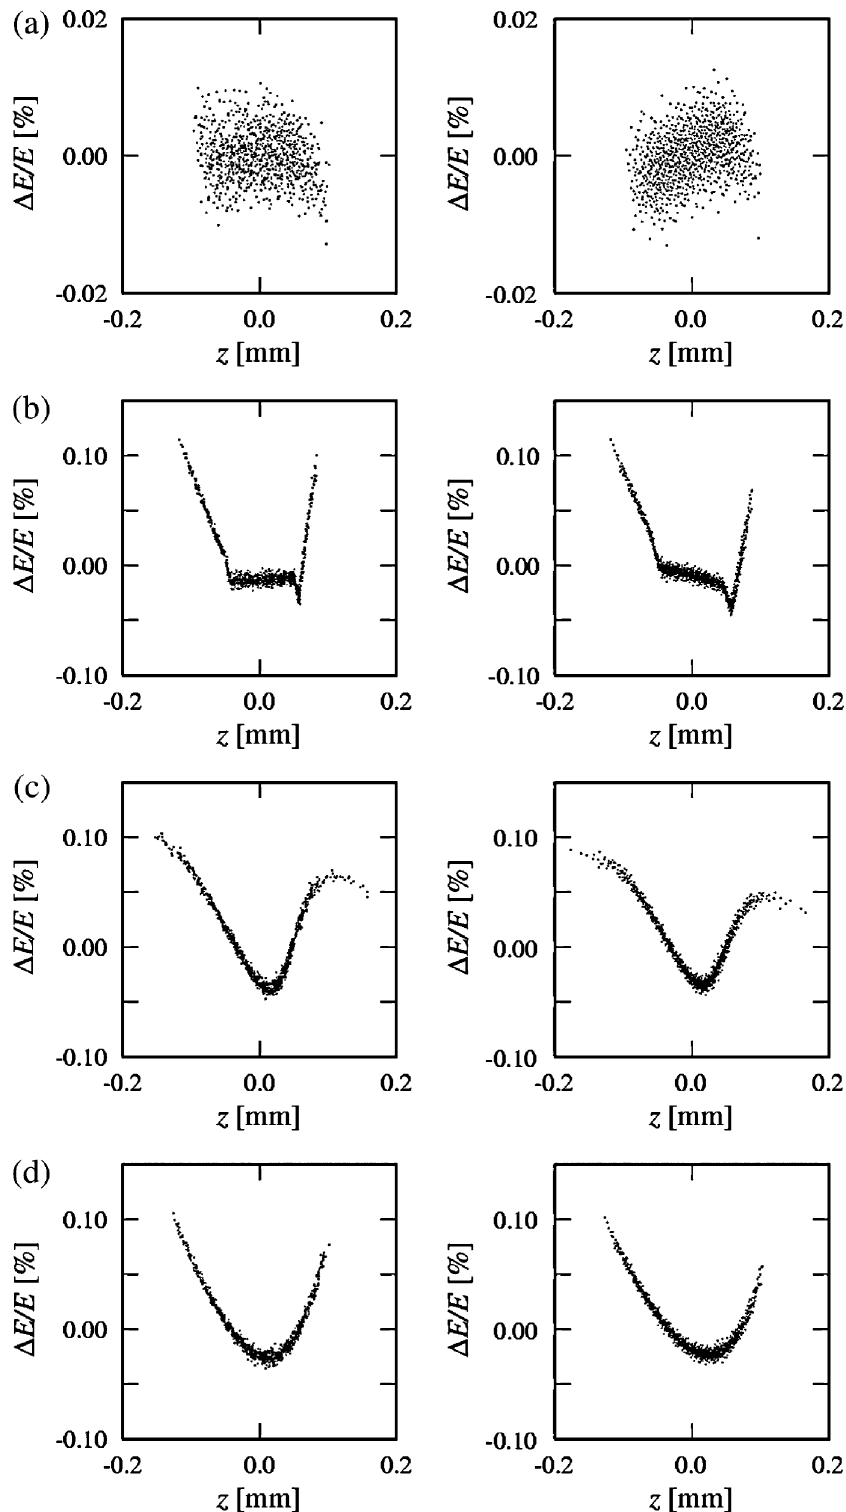
FIG. 4. Phase space after compression and acceleration to 1.7 GeV, for bunches with peak current of 50 A before compression. The bunch tail is at positive z . LITRACK (with resistive impedance) results are on the left, while ELEGANT results with coherent radiation are on the right. (a) Trapezoidal bunch with 2-mm flattop, 1-mm head and tail, tracked without collective effects. (b) Trapezoidal bunch with 2-mm flattop, 1-mm head and tail. (c) Gaussian bunch with (cid:5)